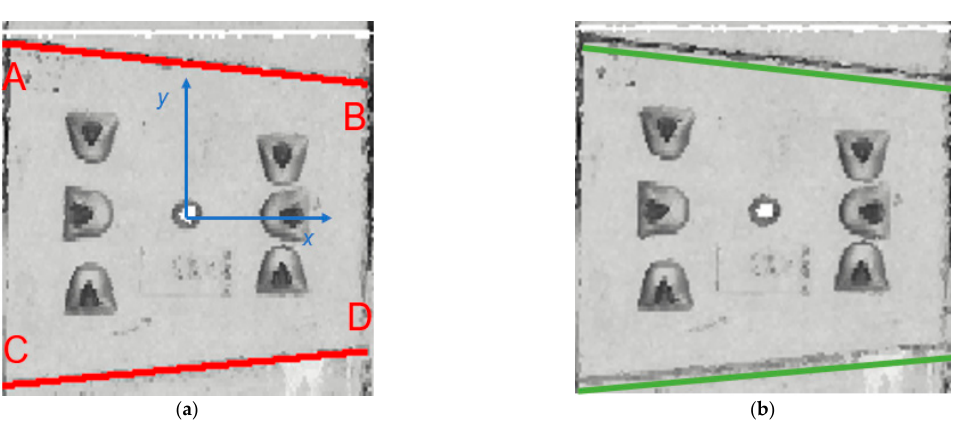
Figure 14. Positioning effect of longitudinal seams in the data loop of the survey area. For the two longitudinal seams formed by the capping block and its left and right adjacent blocks in the same ring, the proposed method is compared with Sun et al.’s method [35], as shown in Figure 15. Black and red lines represent the seam in the point cloud and longitudinal seam located by the proposed method, respectively, as shown in Figure 15a. Green lines represent the longitudinal seam located by the method proposed by Sun et al., as shown in Figure 15b.